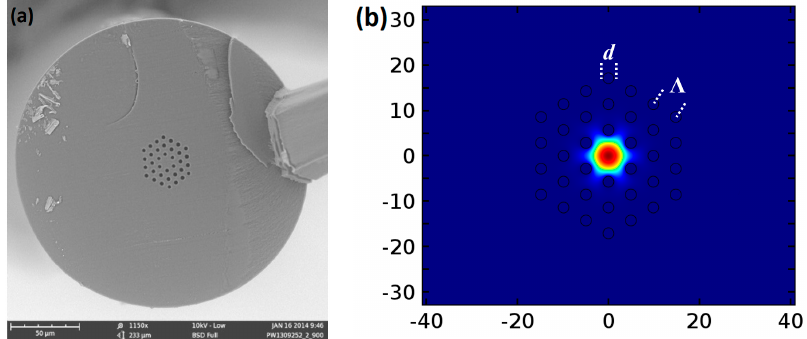
Figure 1. ( a ) Scanning electron microscope picture of an microstructured polymer optical fiber (MPOF). ( b ) Simulated fundamental mode field distribution for the MPOF at 600 nm.